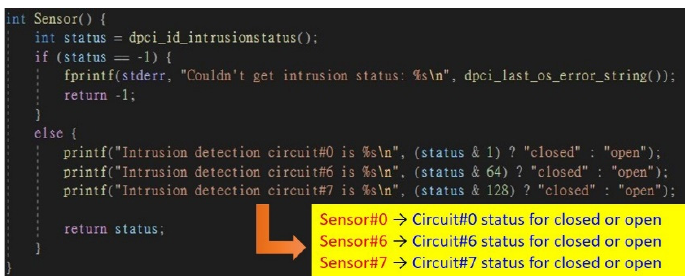
Figure 15. Sensor detection function.